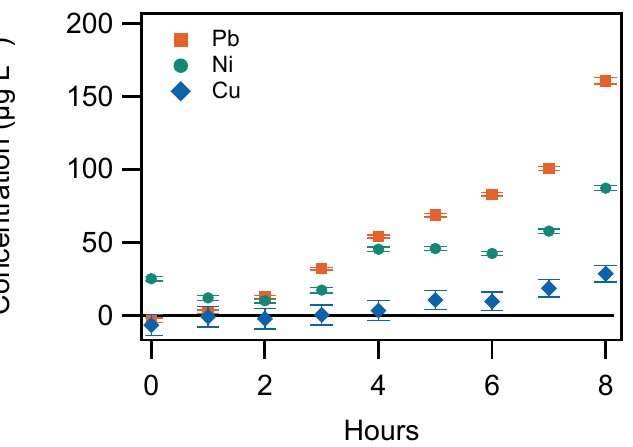
Figure A2. Concentrations of lead (Pb), nickel (Ni), and copper (Cu) for e-liquid over time with coil placed in e − liquid. Error bars represent standard deviations of triplicate measurements of individual liquid samples. Chromium concentration was less than the LOD in all cases and is not